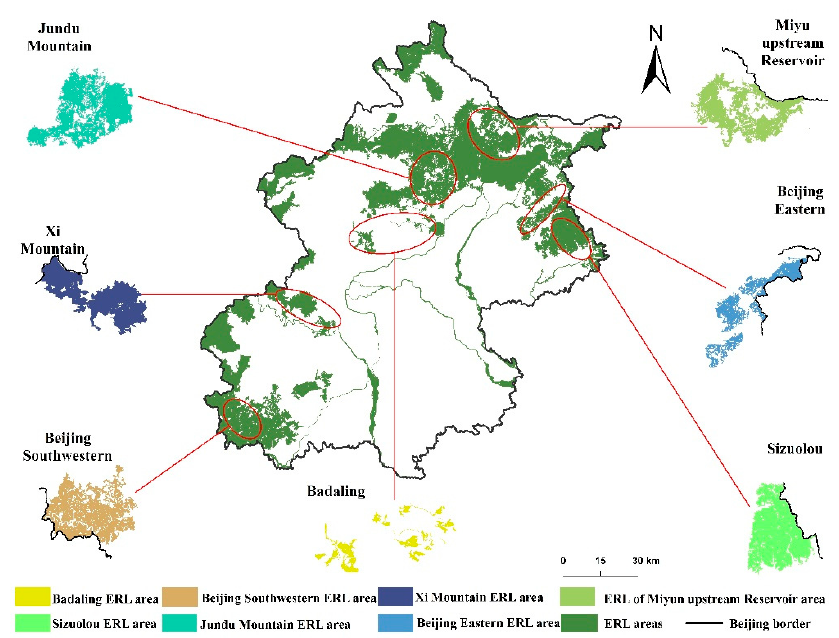
Figure 1. The spatial distribution of Beijing and ERL areas.